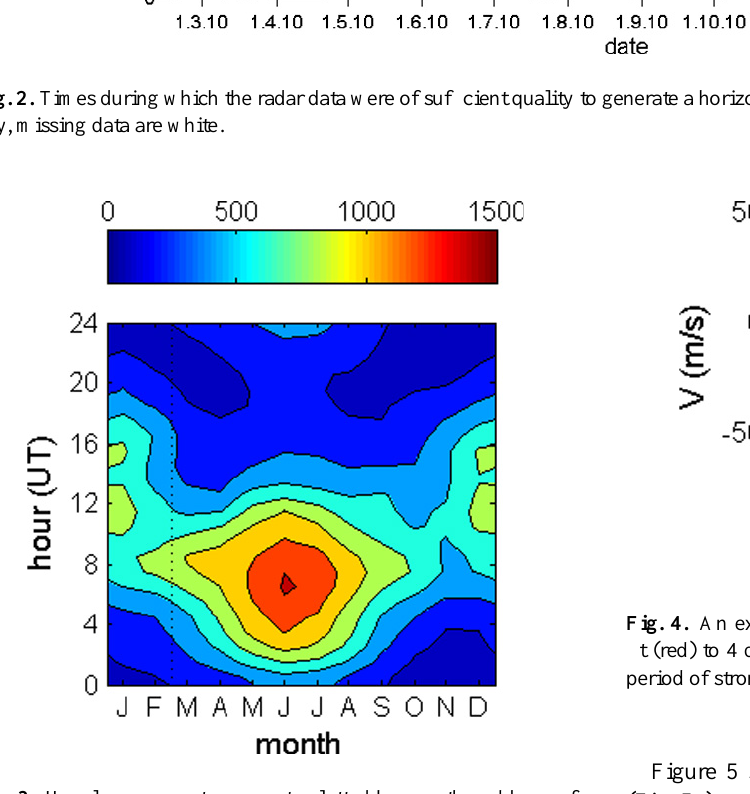
Fig. 3. Hourly mean meteor counts plotted by month and hour of day. The vertical dotted line on this and subsequent annual plots represents the break between data recorded in 2010 and 2011 (see Fig. 2).